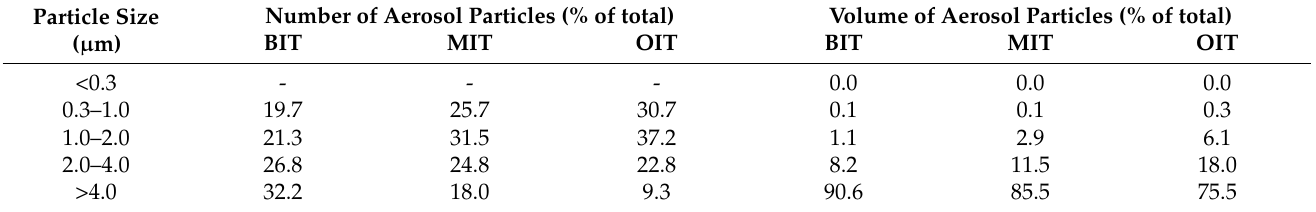
Table 1. The fraction of the particle number and the volume of biocide aerosols during the nebuli- zation .